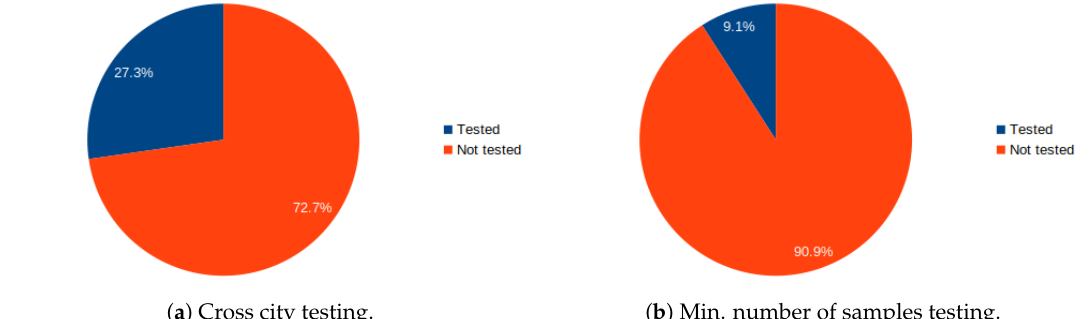
Figure 9. Tests applied for verification of cross city applicability and for the minimum number of samples needed by a classifier to perform